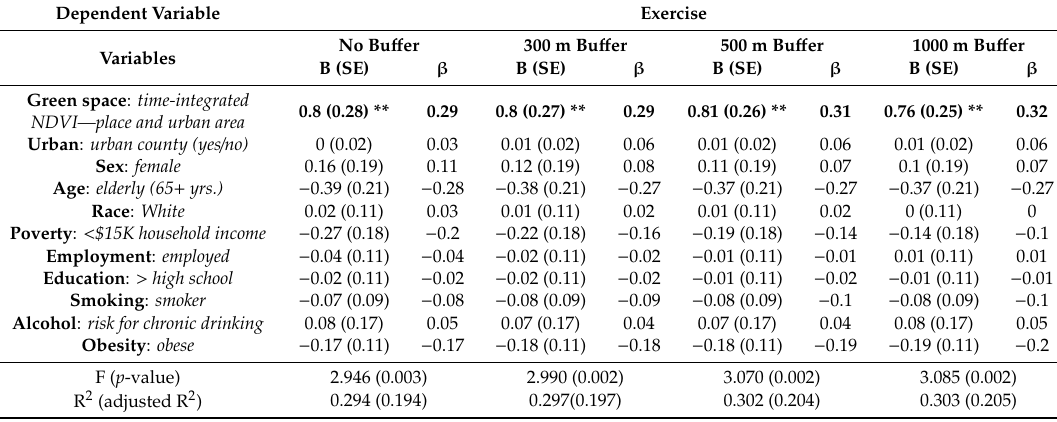
Table 3. Multiple regression analysis for exercise in varying bu ff er sizes of green space boundaries in